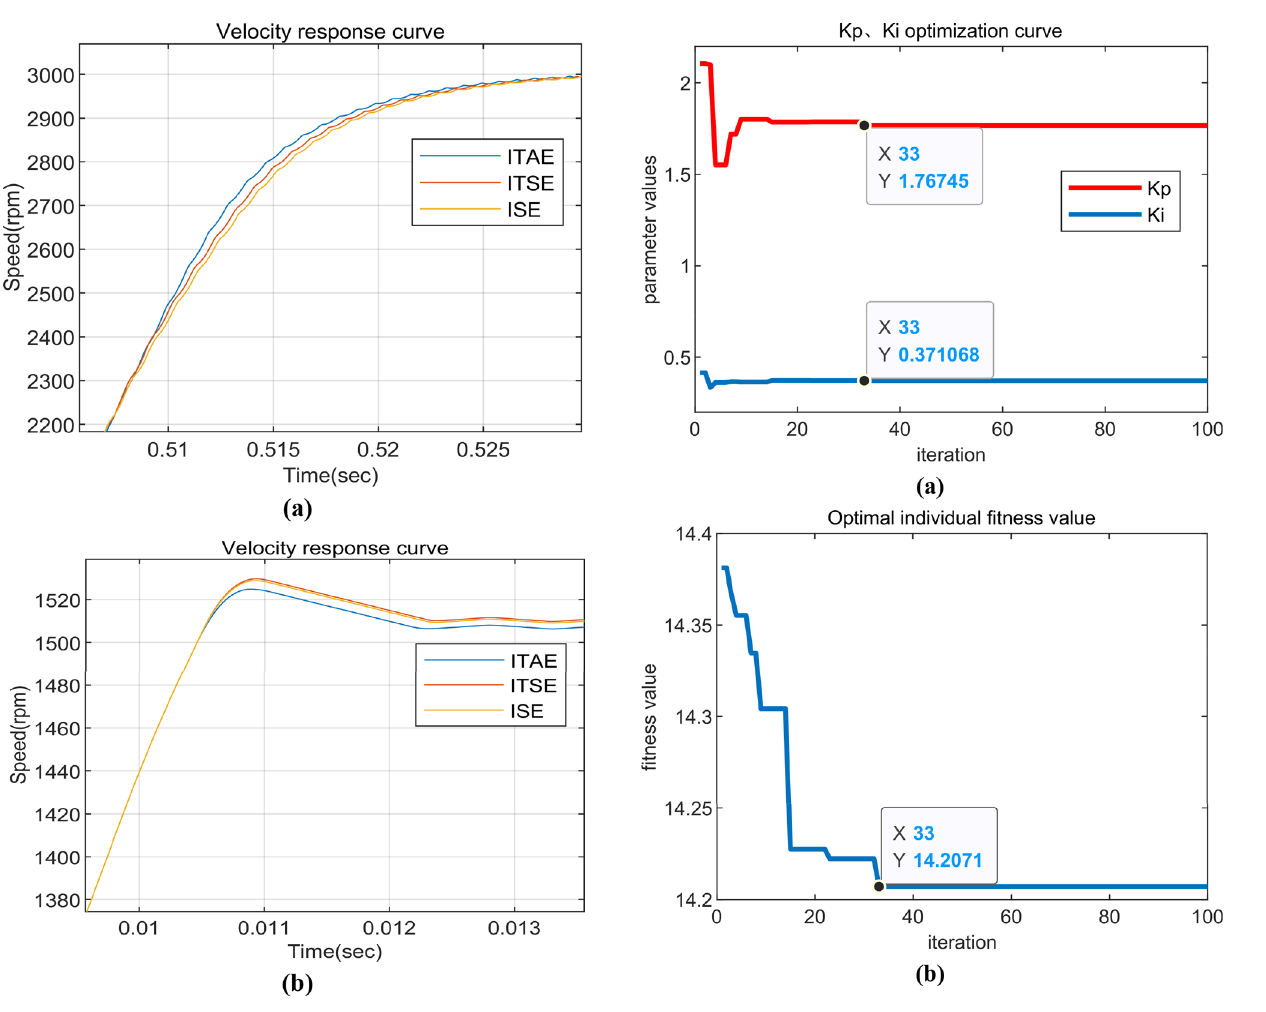
Fig. 10 Optimized enlargement of the three performance indica- tors under the velocity response curve